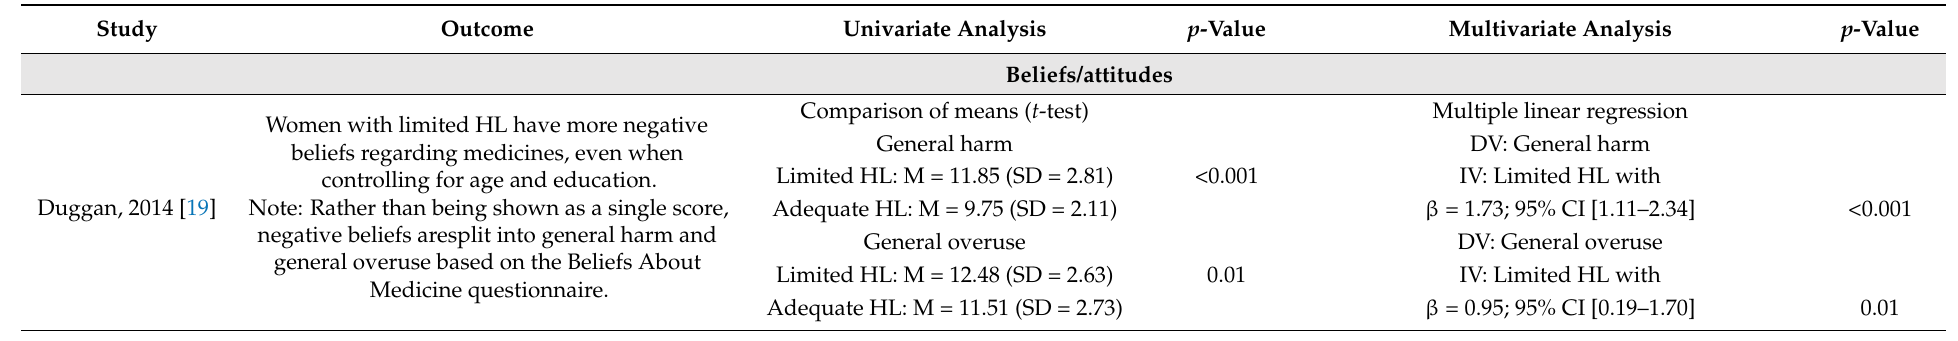
Table 5. Studies that indicated an association between health literacy and other outcomes during